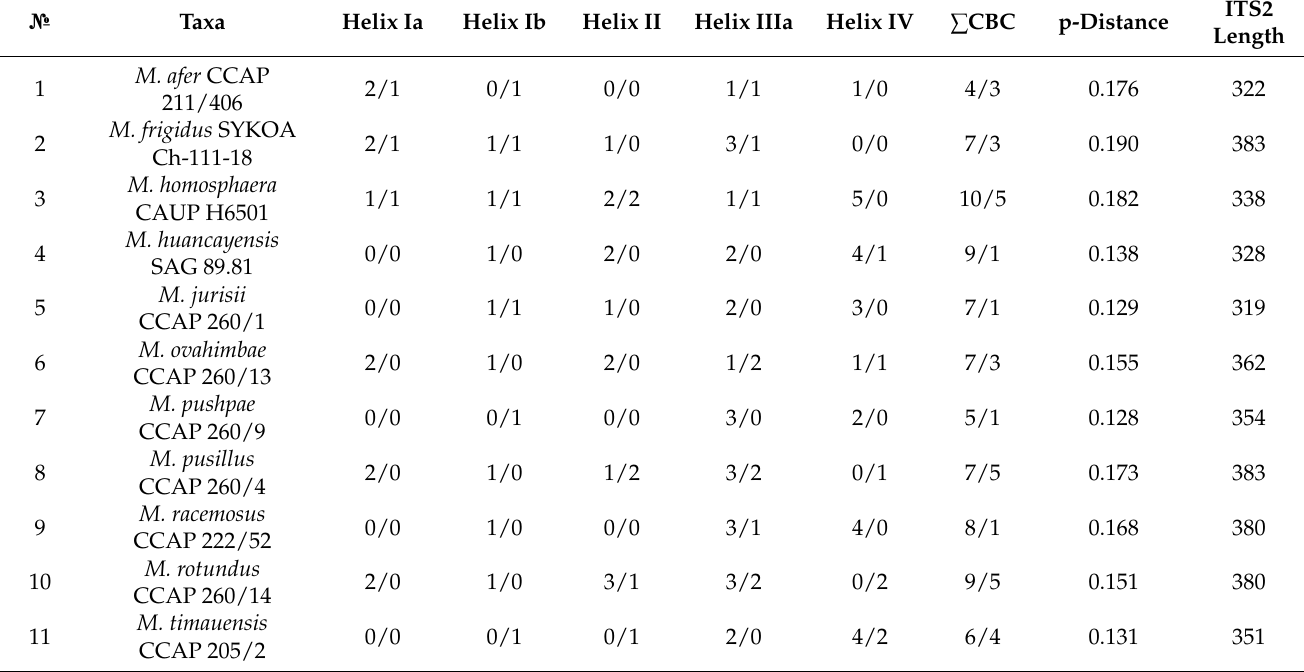
Table 2. Number of CBCs/ hemi-CBCs in ITS2 and based on this marker p-distances between M. hindakii M 323 (367 nt) and other species of the genus.